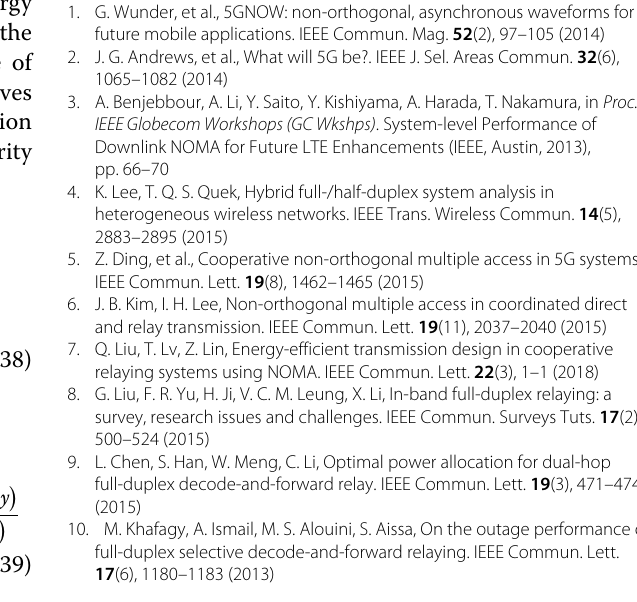
BS and U2 is fixed, i.e., 24 m. It is observed that the aver- age energy efficiency first increases with the increase in the distance between relay and the BS and then decreases with the increase in the distance between relay and the